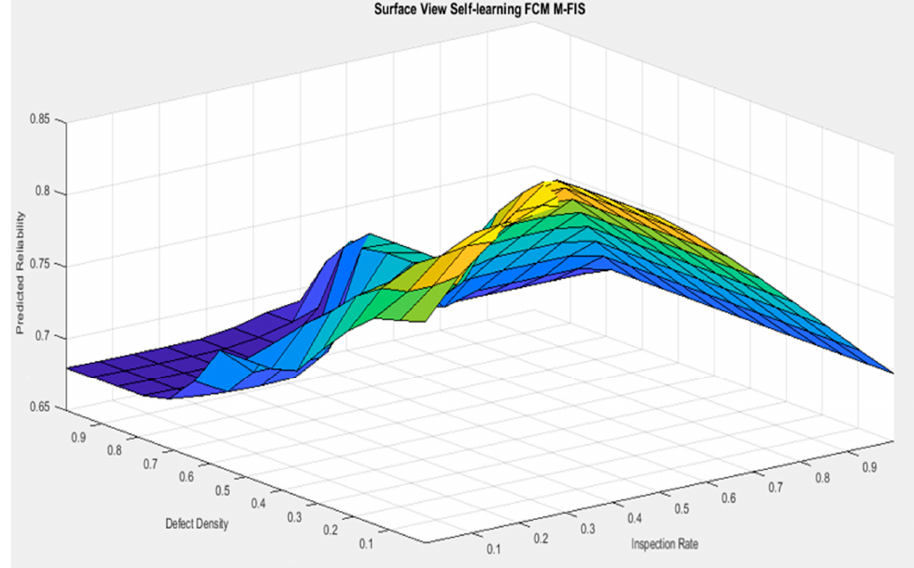
Figure 6. Surface view of self-learning (FCM)